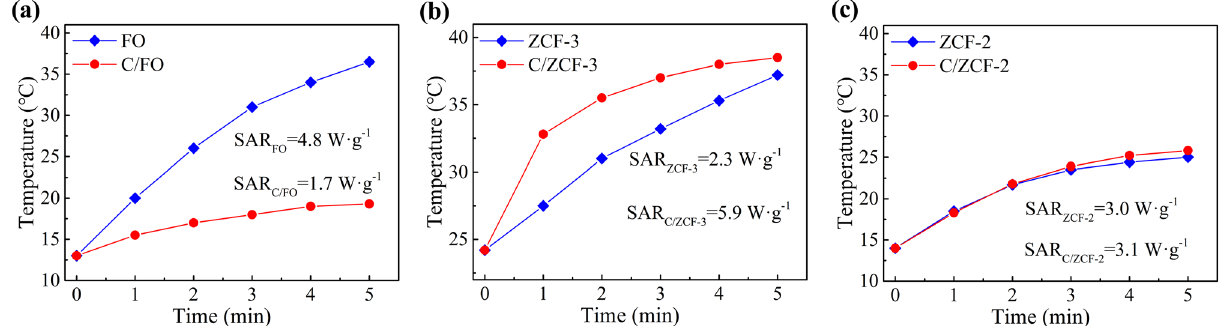
Figure 4. The magnetic heating curves of the samples under the AMF with 16 kA/m and 100 kHz: ( a ) FO and C/FO, ( b ) ZCF-3 and C/ZCF-3, ( c ) ZCF-2 and